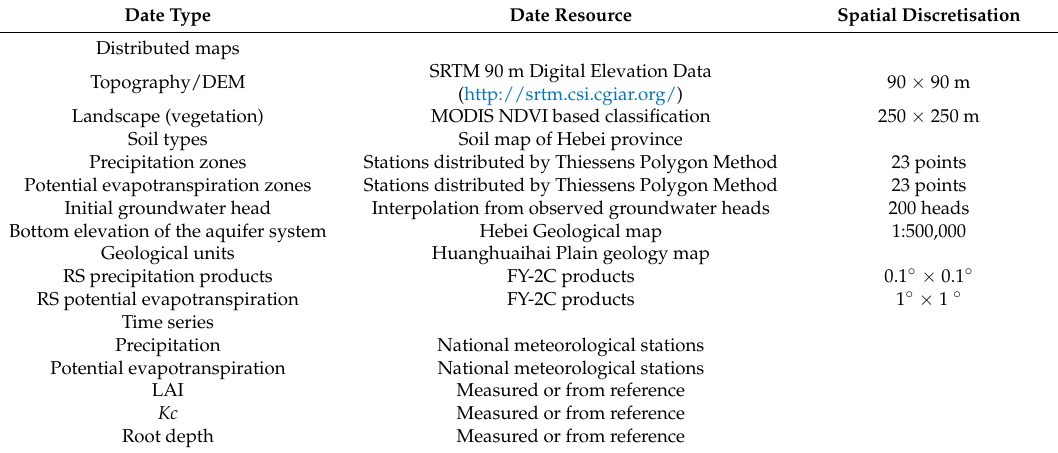
Table 1. Maps and time series used as input to MIKE SHE with reference to the source and the spatial discretization.